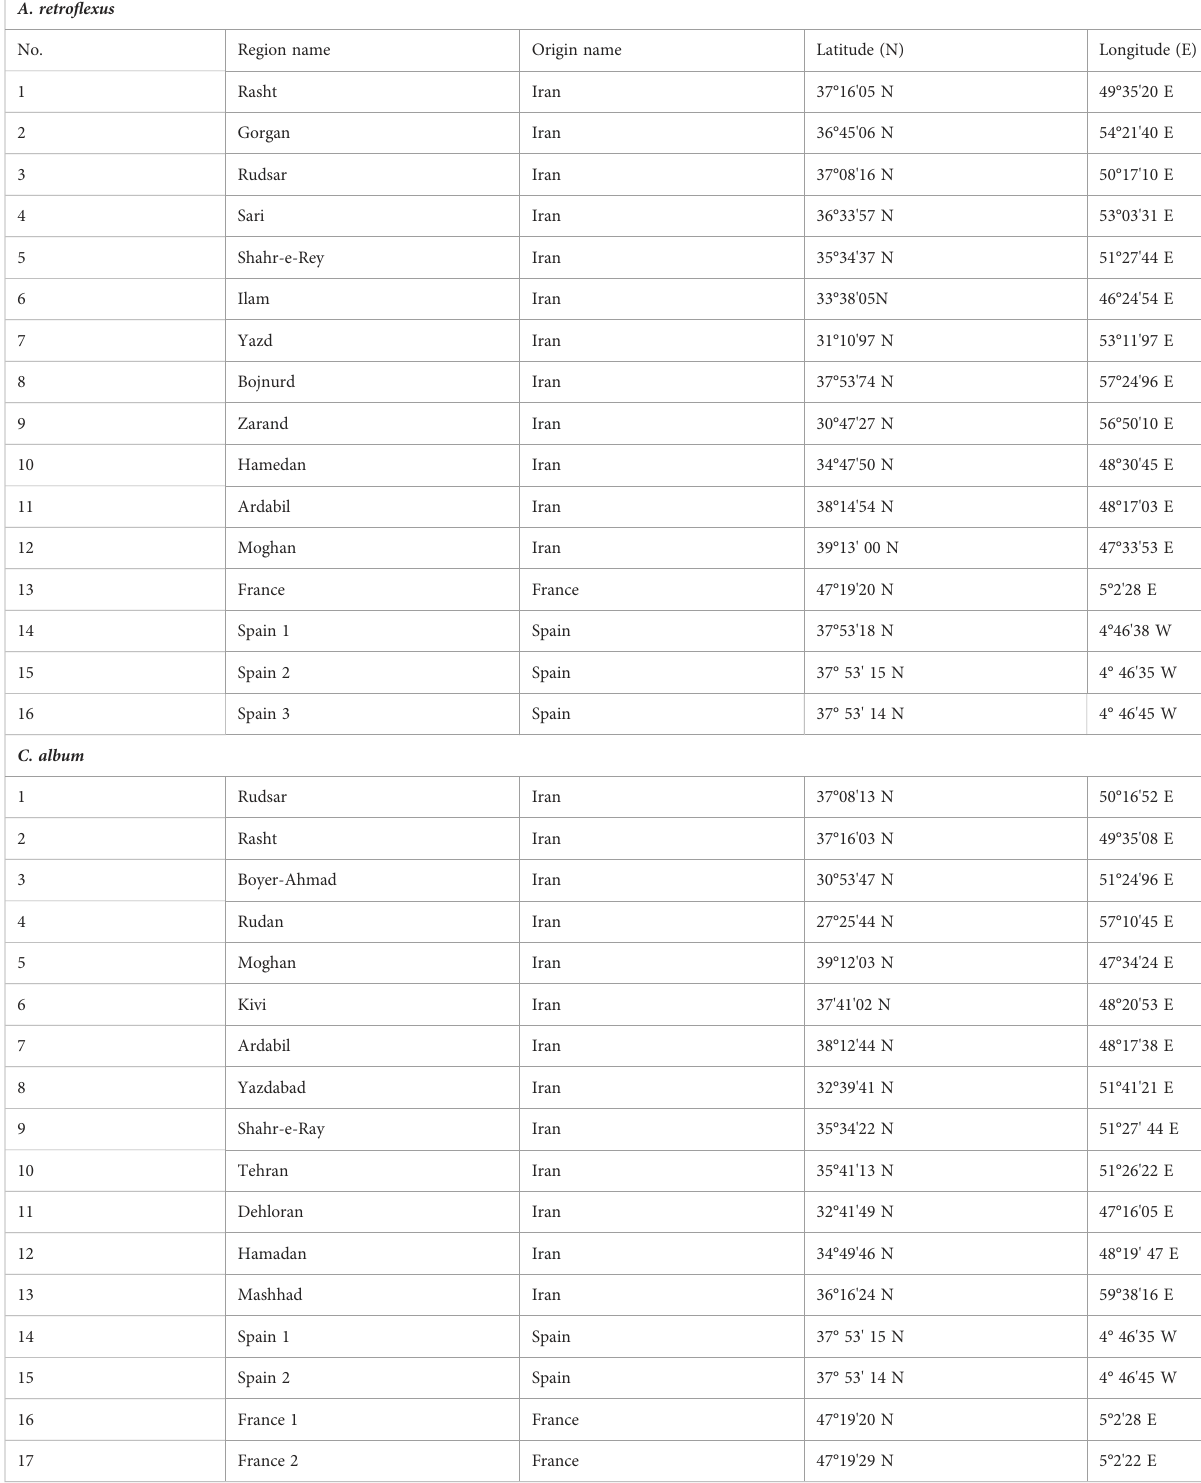
TABLE 1 The list of 16 A . retro fl exus and 17 C . album populations evaluated in this study with their coordinate and origin